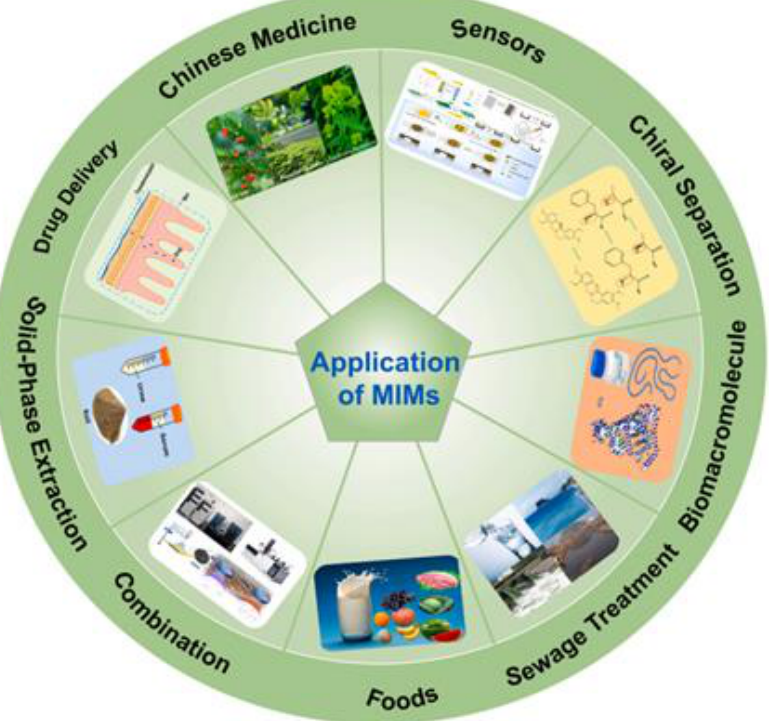
Figure 10. Application areas of MIMs. (Reprinted with permission from Ref. [206]. Copyright 2021 Elsevier.)